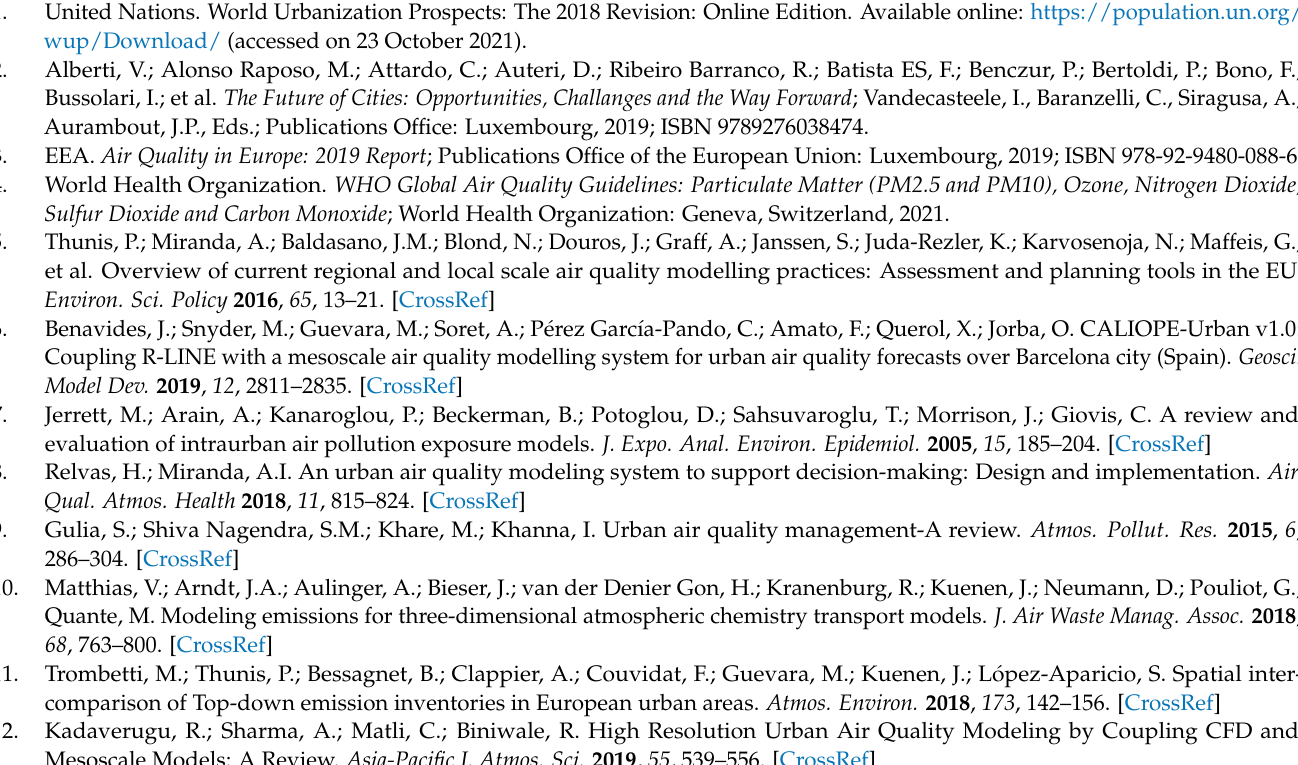
Figure A2. Daily PM 2.5 ( μ g m − 3 ) scatter plots for ( a ) Athens, December 2018 and ( b ) Hamburg, 2016. The observed (obs) versus modeled (mod) mass concentrations are shown, the latter when applying the original CAMS emissions (CAMS no proxy) and high-resolution emissions using the newly developed approach (UrbEm).